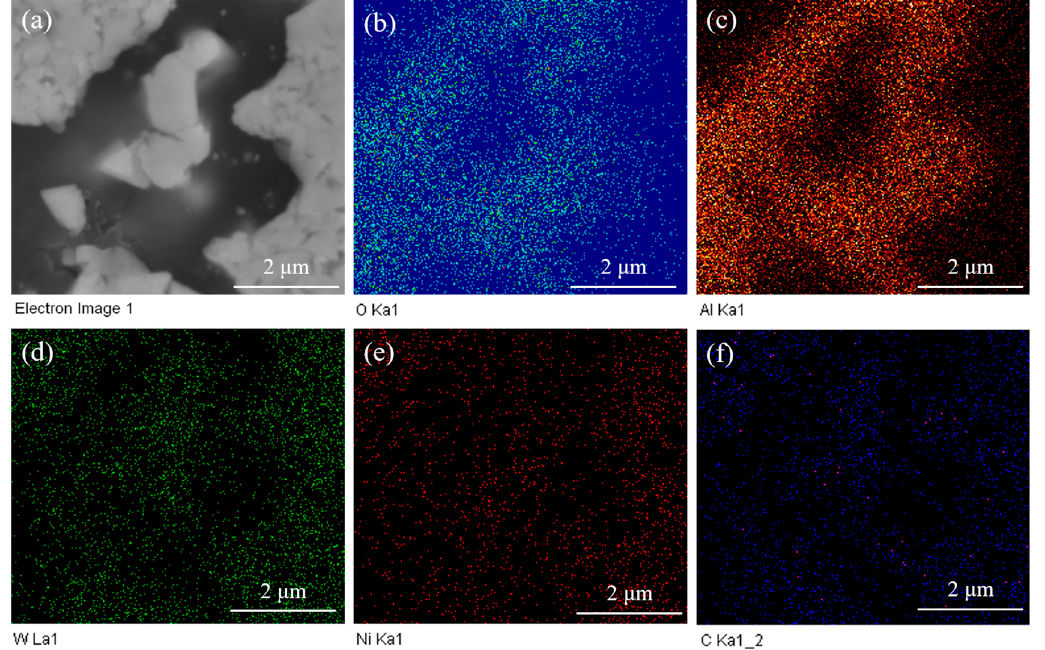
Figure 3. EDS maps of a sintered WC-10Ni 3 Al composite using CH 3 CH 2 OH as ball-milling suspension, ( a ) SEM image; ( b ) O, ( c ) Al, ( d ) W, ( e ) Ni, ( f )